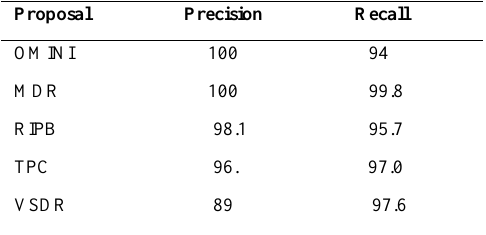
Table 2. Performance of some related works.